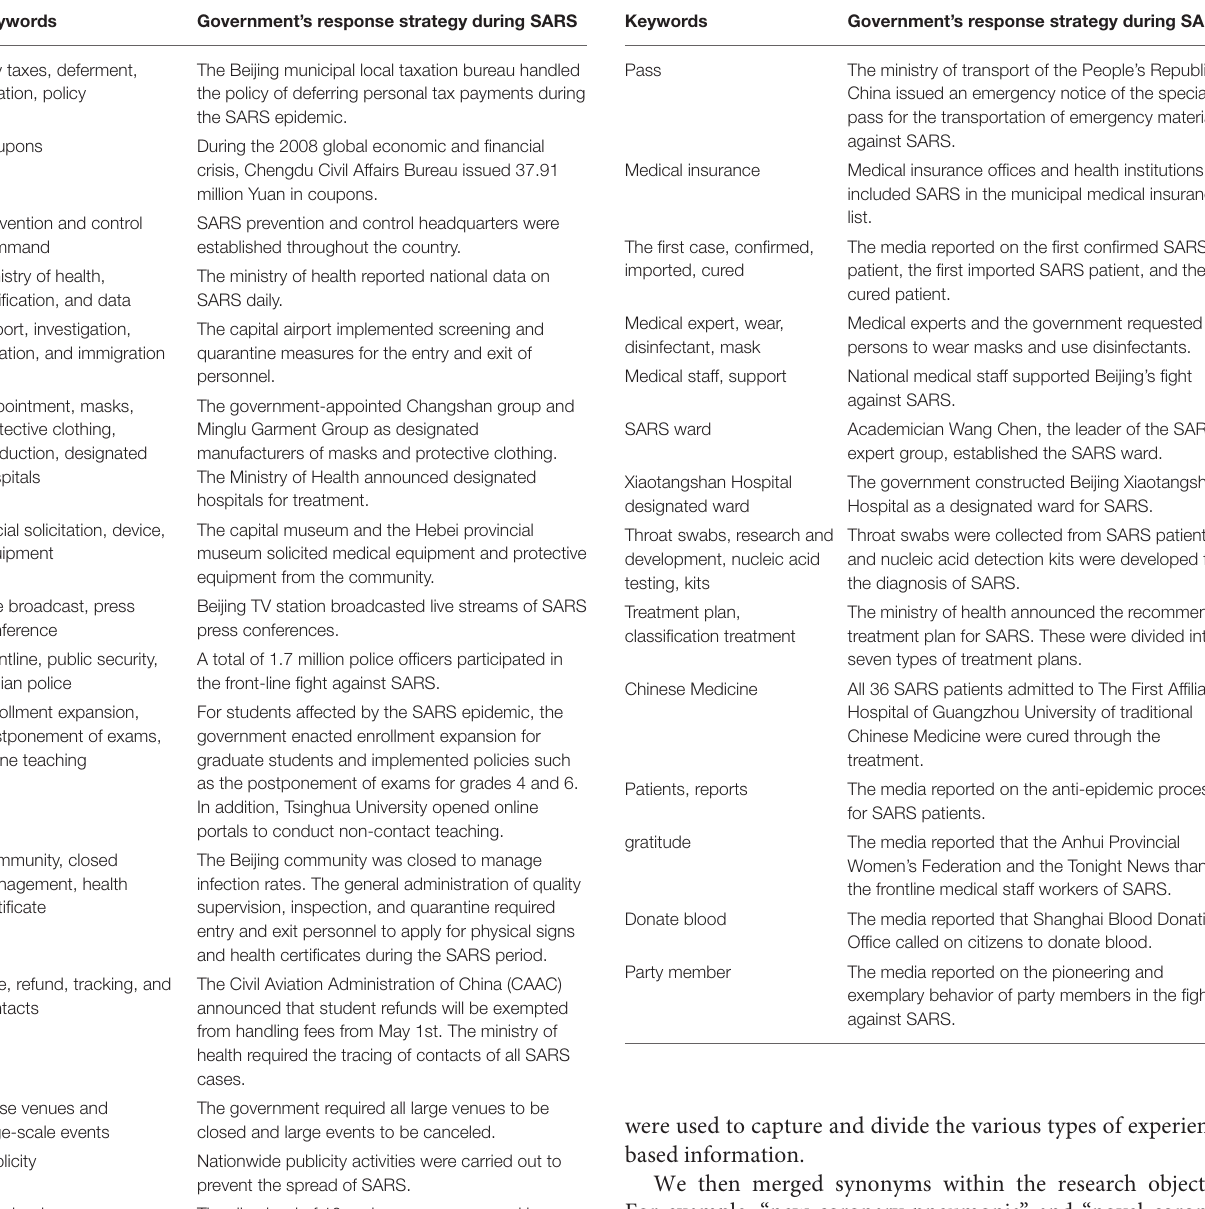
TABLE 3 | China’s main response strategies and keywords for